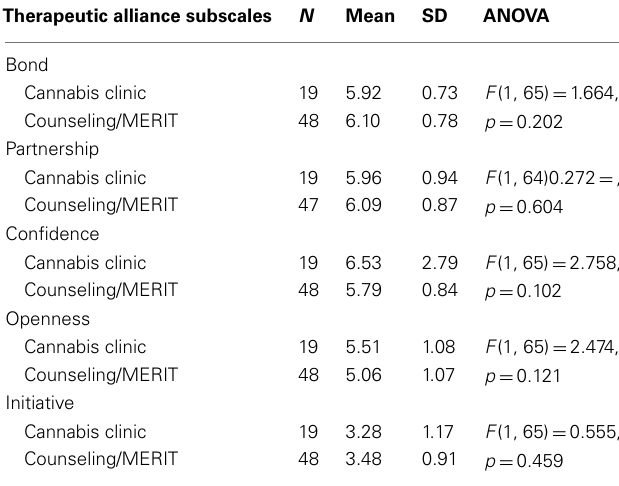
Table 1 | Pearson correlation analysis for depression, anxiety, stress scores (DASS-21), subscales of theAgnew-Davies Relationship Measure (ARM) of therapeutic alliance (client-rated) and past-month cannabis use (OTI q Score).